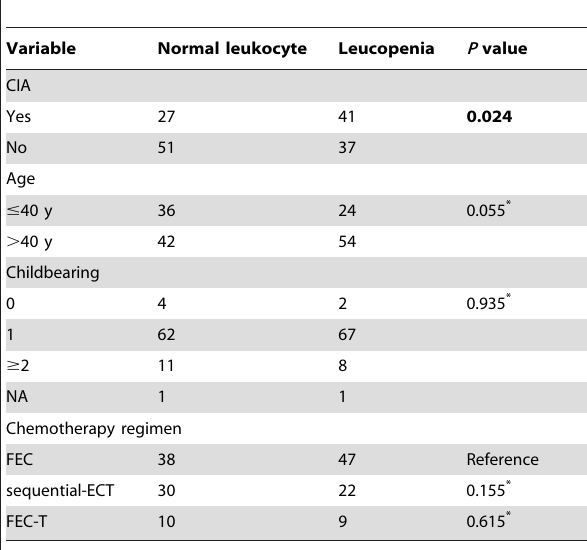
Table 4. Patient characteristics in leucopenia group and normal leukocyte